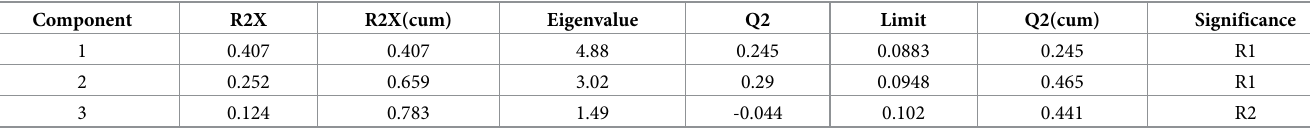
Table 1. Analysis results with SIMCA